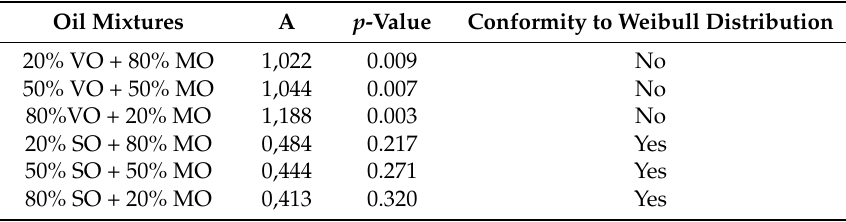
Table 8. Hypothesis test of conformity to Weibull distribution of oil mixtures in AC.